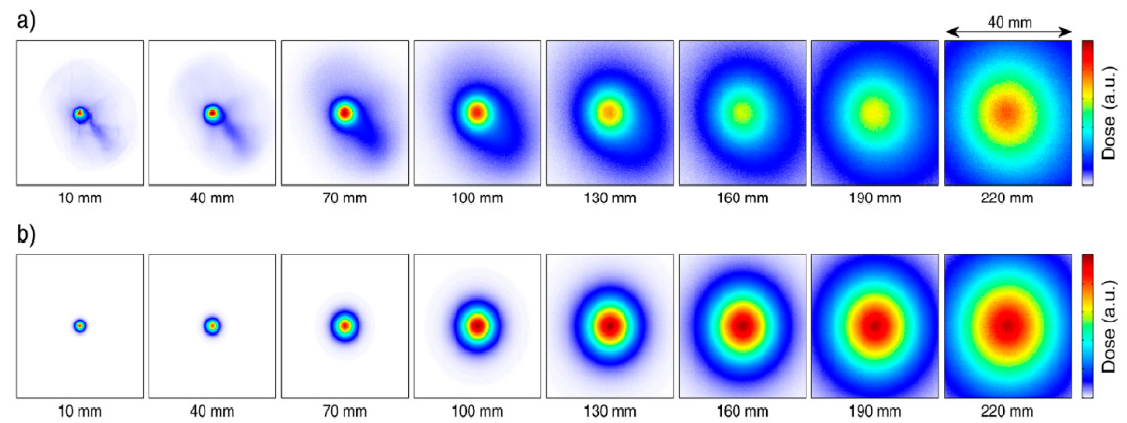
Figure 17. Measured ( a ) and simulated ( b ) two dimensional dose distributions in planes perpendicular to the beam central axis at various depths in a phantom. As the electron beam propagates through the phantom multiple Coulomb scattering occurs which deflects the electrons transversely. Reproduced from [87]. Copyright 2012, American Association of Physicists in